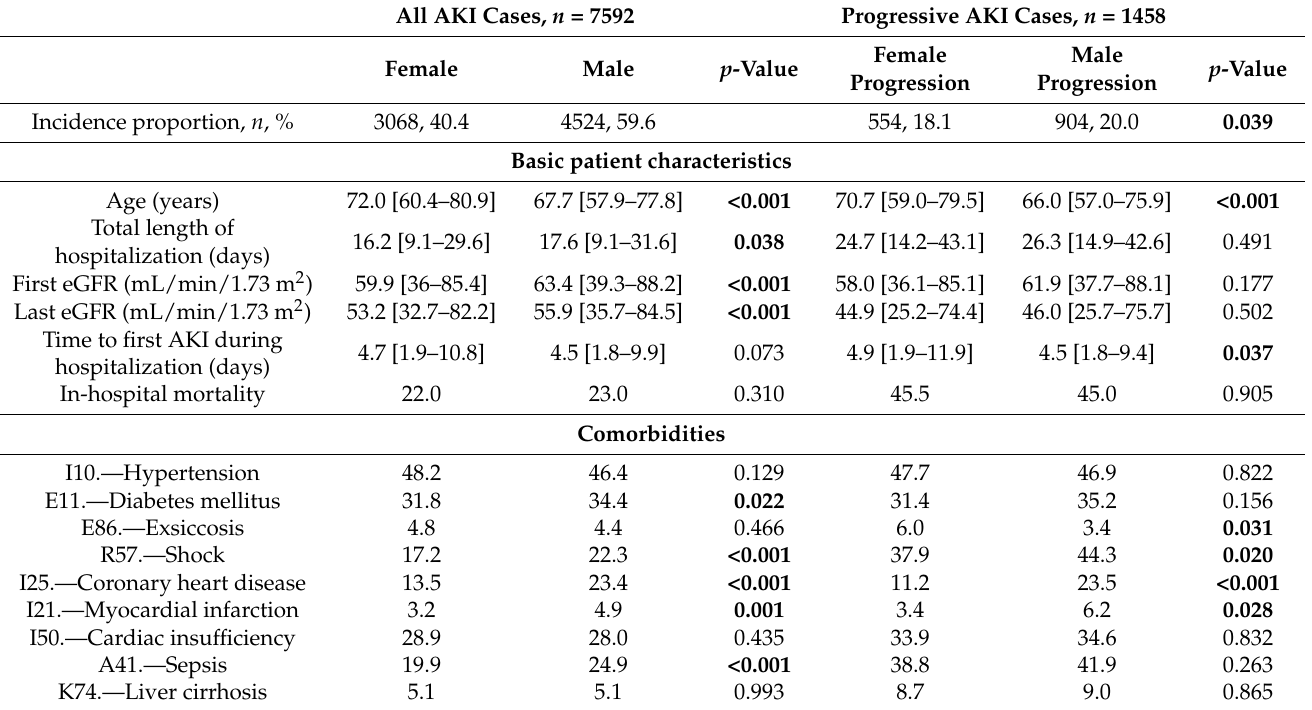
Table 2. Comparison of female and male patient characteristics considering all AKI cases and pro- gressive AKI cases. Variables are given as medians [interquartile range] or percentages. n —number of cases. Significant p -values (< 0.05) highlighted as